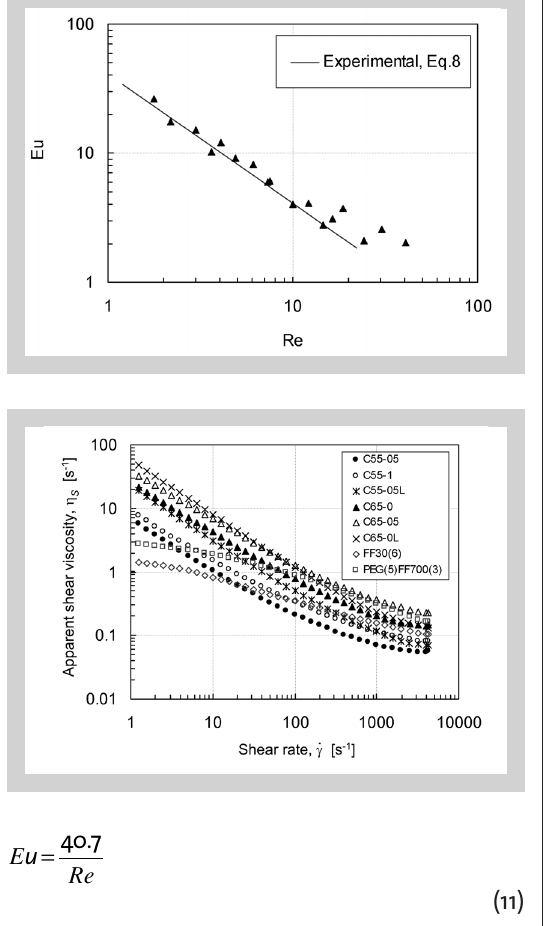
fluids.Figure 4 (left): Sketch of the laboratory jet coater. Figure 5 (right above): Calibration curve in terms of the dimensionless Euler number versus Reynolds number for Newtonian fluids. Figure 6 (right below): Steady shear viscosity as a function of shear rate for all the